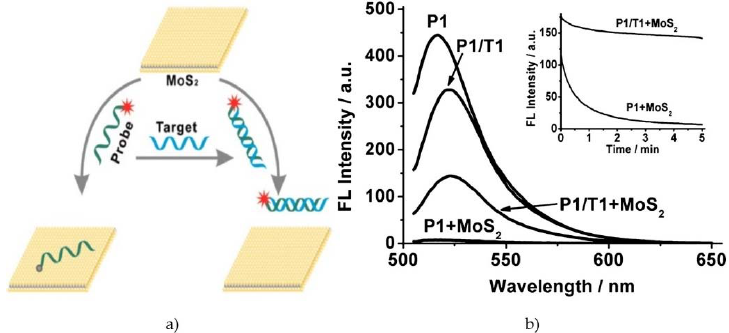
Figure 8. ( a ) Schematic illustration of the fluorometric DNA assay; ( b ) effect of MoS 2 on the quenching intensity of the dye-labelled ssDNA probe P1 ( Homo sapiens tumor suppression gene) and retained fluorescence for P1/T1. A single-layer MoS2 nanosheet exhibits a high fluorescence quenching ability and different affinity toward ssDNA versus dsDNA. The inset of (b) represents the quenching kinetics of the sensing process. Adapted with permission from [56]. Copyright 2013 American Chemical Society.